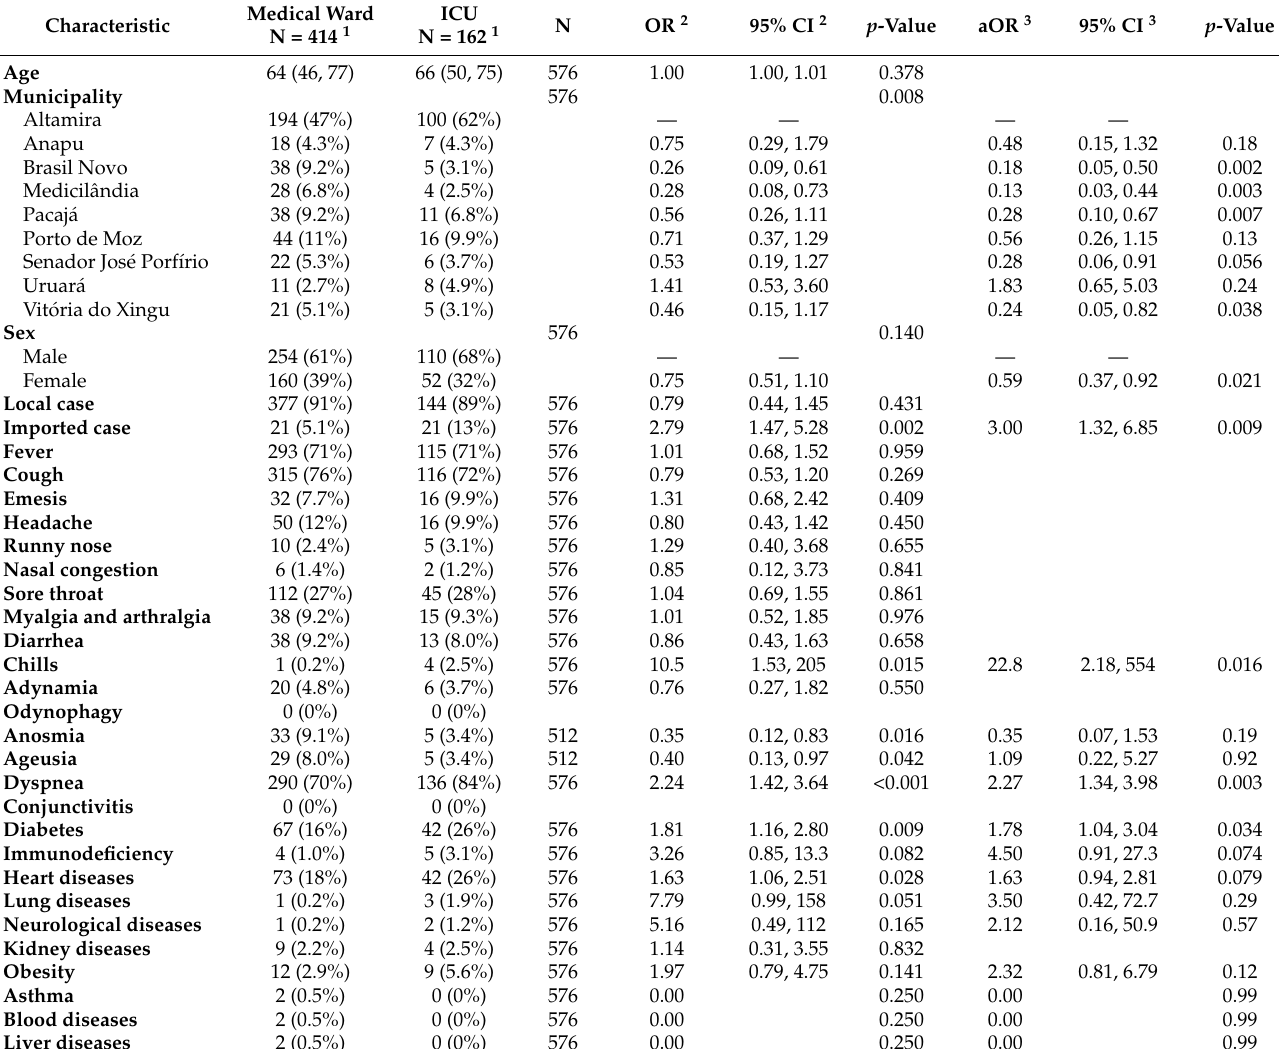
Table 4. Sociodemographic factors, symptoms, and comorbidities as predictors of admission to intensive care units (ICU) in relation to admission to a medical